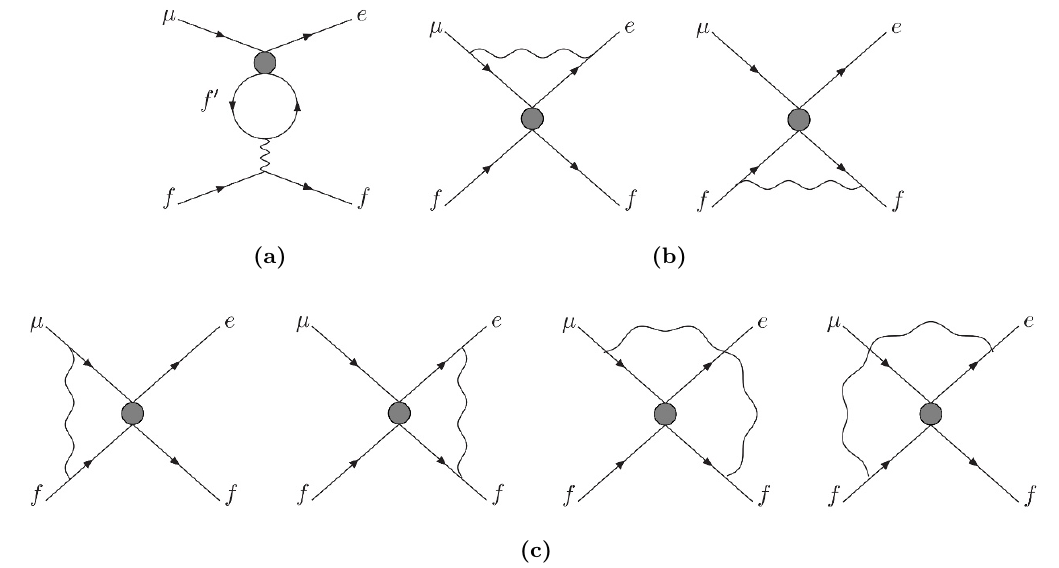
Figure 1. One-loop Feynman diagrams for the mixing of the four-fermion lepton-quark and lepton- tau